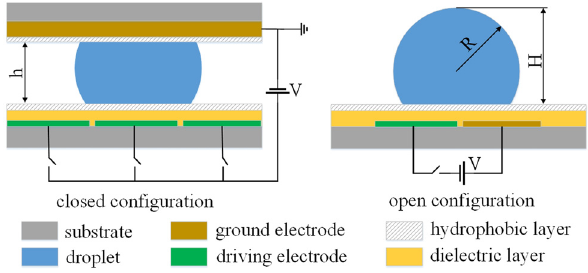
Figure 1: Side - view schematics of closed ( left ) and open ( right ) con fi